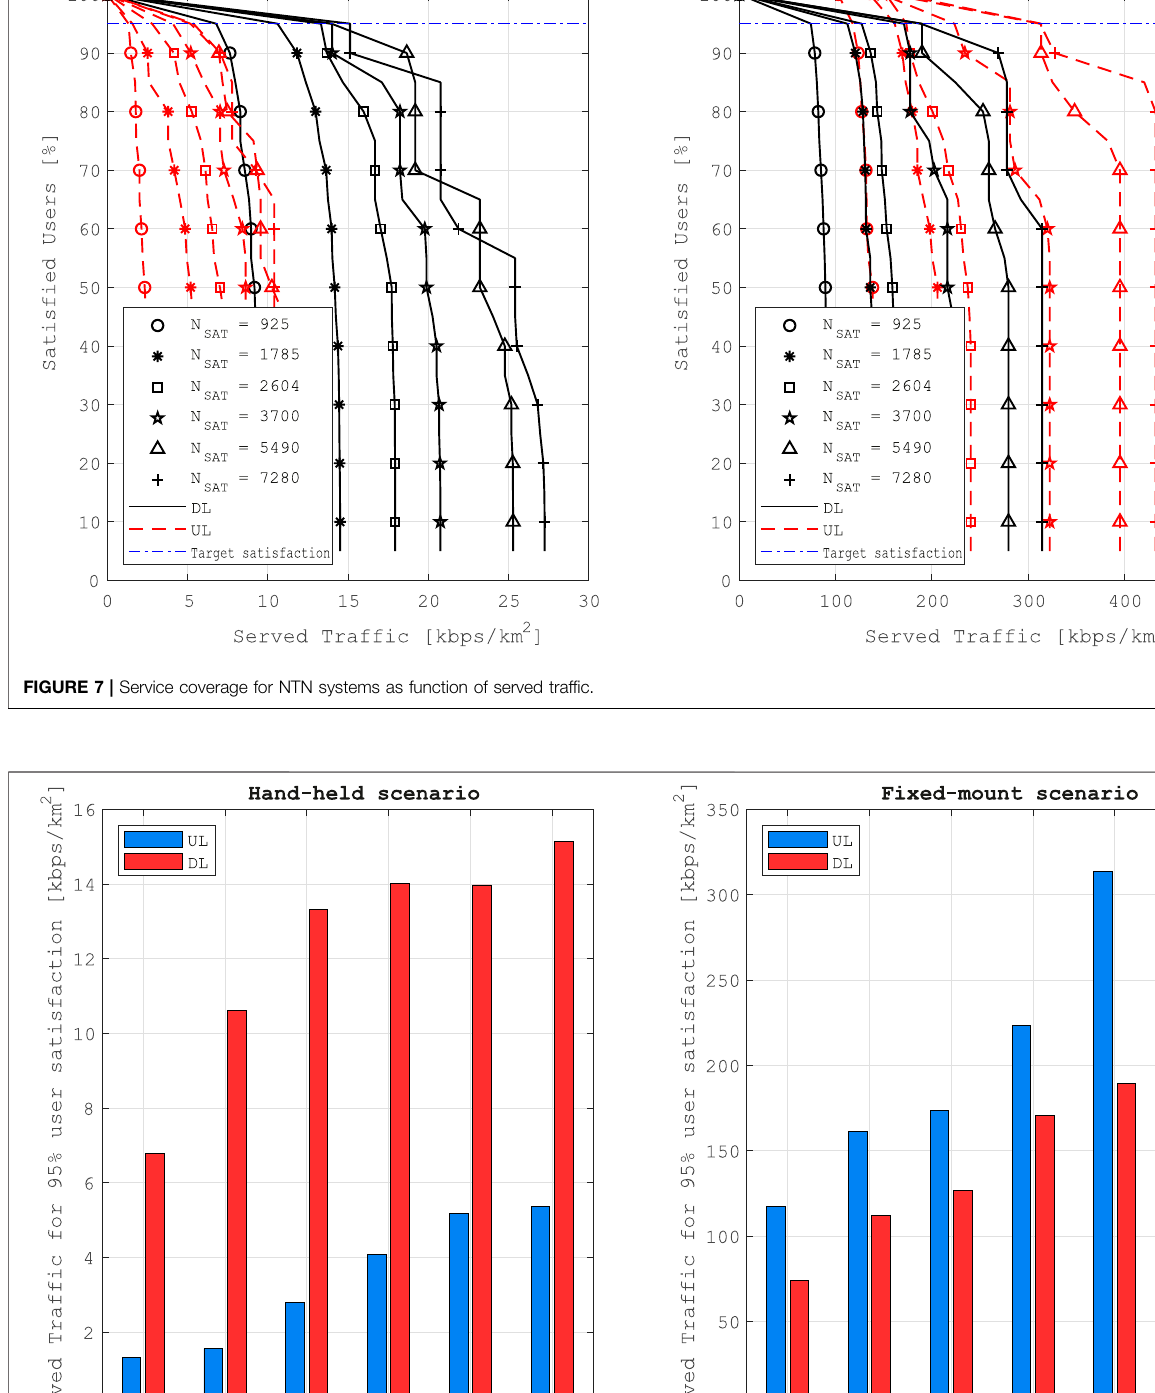
Frontiers in Communications and Networks |